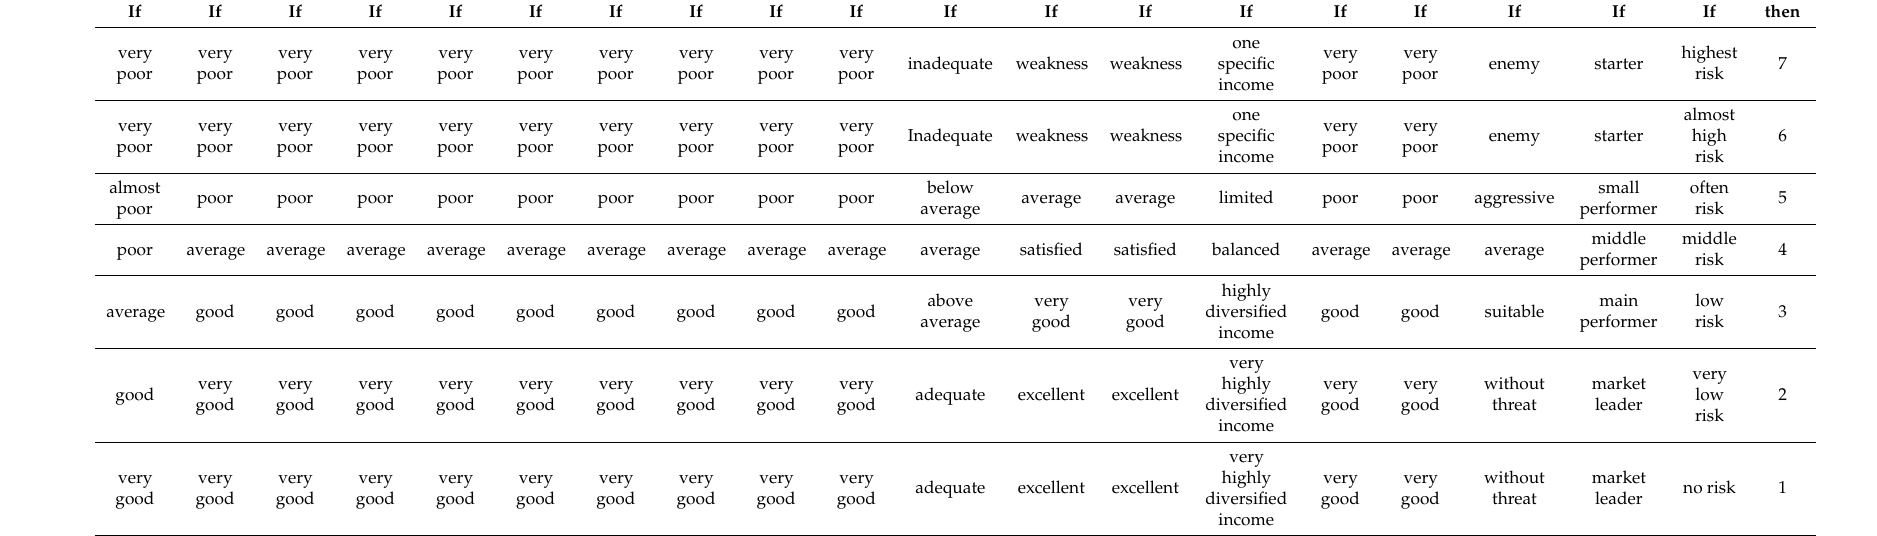
Table 5. IF-THEN rules. For each of the seven evaluation categories, a respective rule is